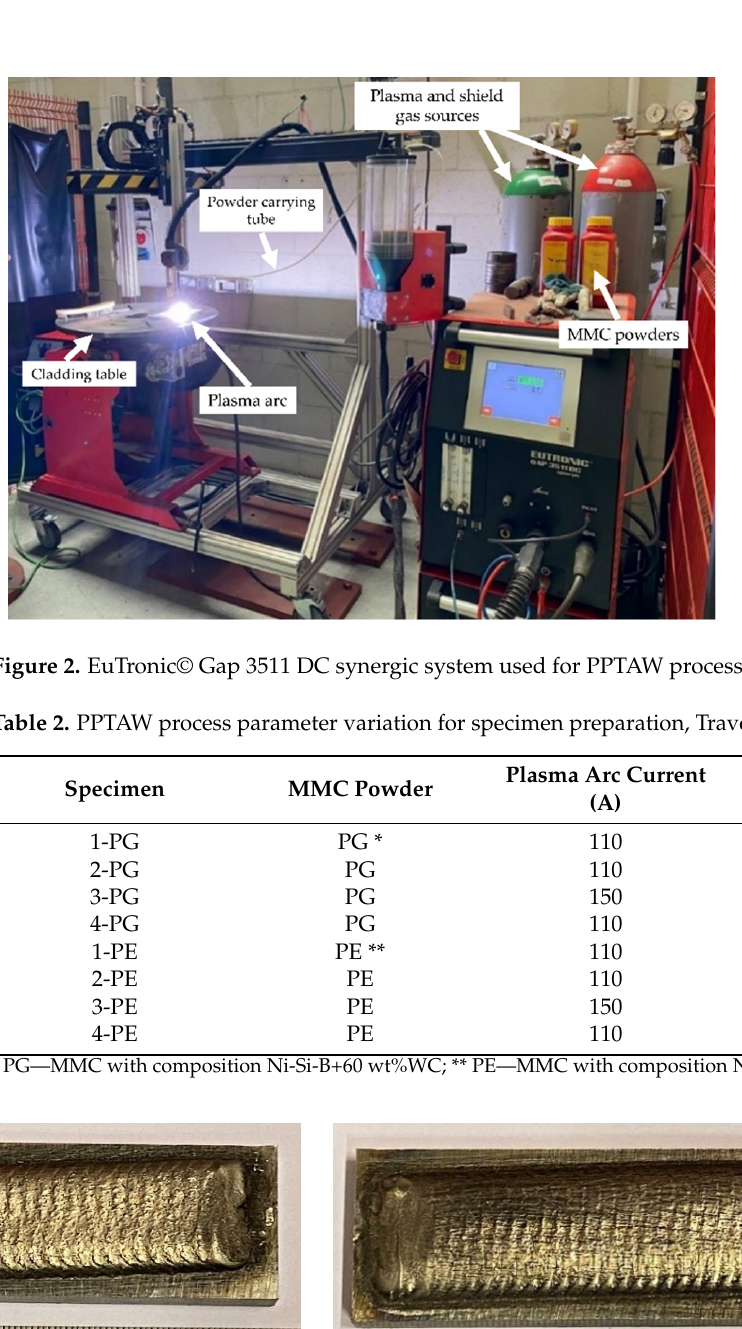
Figure 3. Images of prepared samples showing the as-deposited MMC surface coatings on the